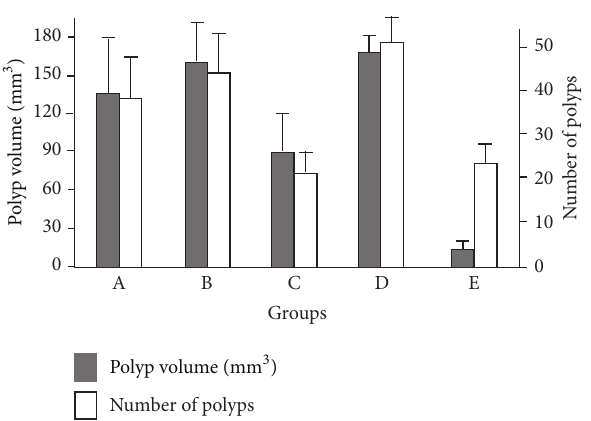
Figure 1: Polyp volume and number in untreated and transplanted Apc Min /+ female mice sacrificed at different time after bone marrow transplantation. The description of the different groups is reported in Section 2.2. Data represent the mean ± SD. Polyp volume and number resulted significantly different among the 5 groups by ANOVA ( 𝑝 < 0.005 ). Polyp volume in A = B = D ̸= Group C ̸= Group E by Tukey test. Polyp number in A = B = D ̸= Group C = E by Tukey test.